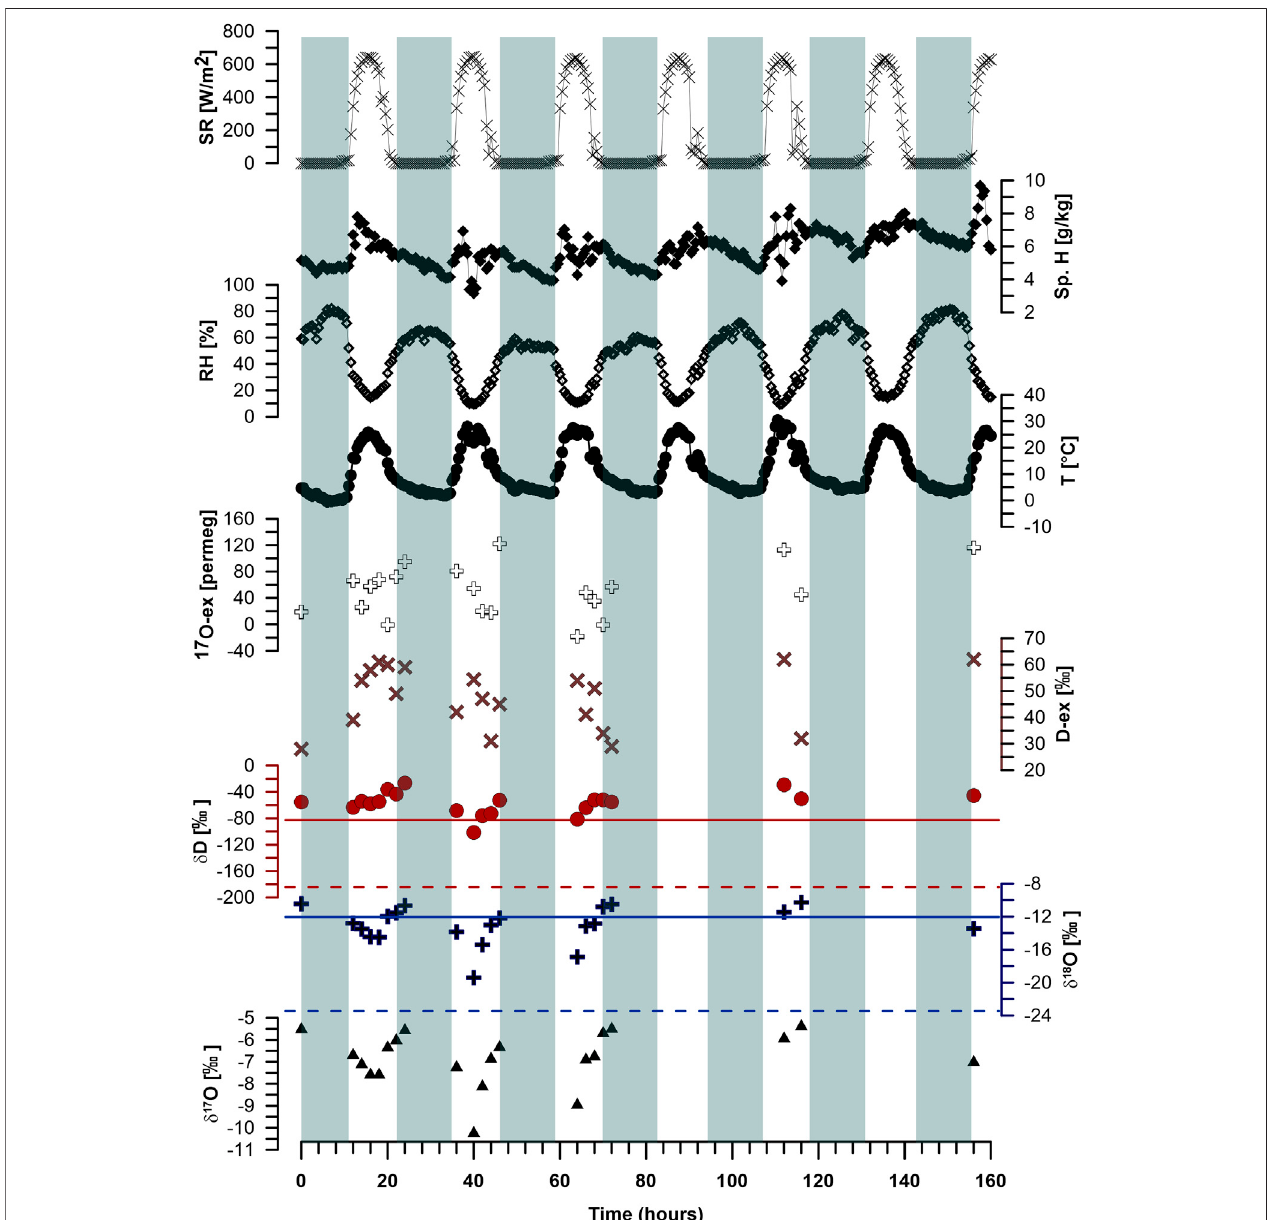
FIGURE3| δ 17 O, δ 18 O, δ D,D-excess, 17 O-excess,Temperature(T)andRelativeHumidity(RH),Speci fi cHumidity(SH)andSolarRadiation(SR)hasbeenshownin this graph for a continuous run of 156 h. Days (white space) and Night (shaded space) are highlighted. Out of 21 sample 15 samples corresponds to day time and six samplescorrespondtonighttime.Allmeteorologicalparameter resultsarerecordedat30 minintervals.Thelowestdeltavaluesathour40arecoincidingwithlowerSH, TandRHshowsaclearanti-correlation.Redsolidandreddashedlinecorrespondstothe δ DofIceandIcevapor,respectivelywhilebluesolidandbluedashedline corresponds to δ 18 O Ice and Ice vapor, respectively.